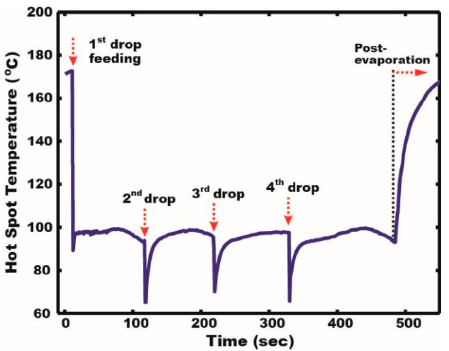
Figure 6. Continuous thermal mitigation by delivering multiple coolant droplets on SDMF. Droplets were successively transported to the hydrophilic hot spot and mitigated the temperature below 100 °C.